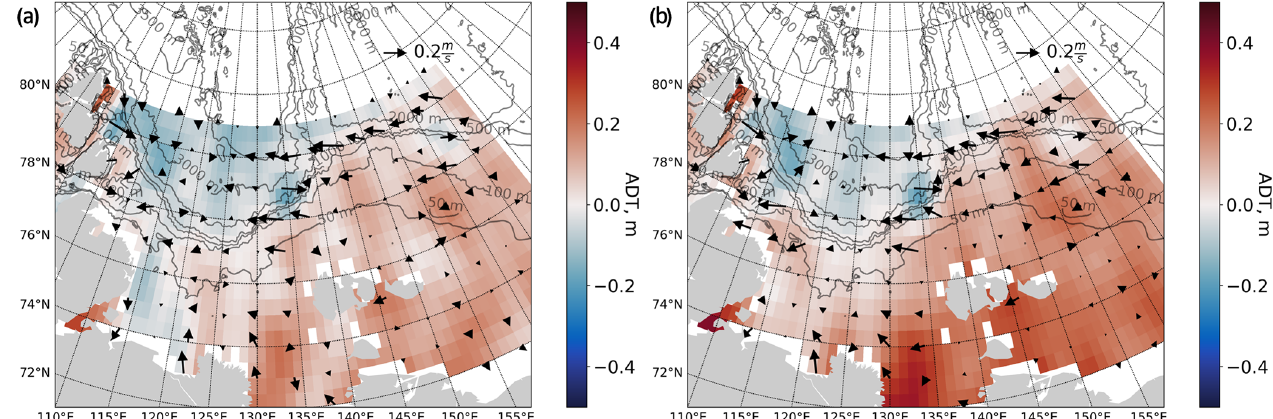
Figure A1. Absolute dynamic topography (m) and geostrophic currents (ms − 1 ) in August (a) and September (b) 2018, calculated from DTU monthly sea level